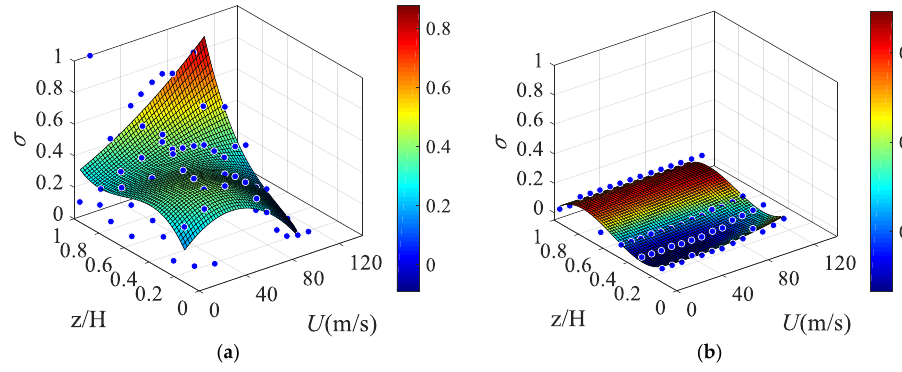
Figure 7. Standard deviation variation for Mode #1 along wind ( a ) and across wind ( b ).